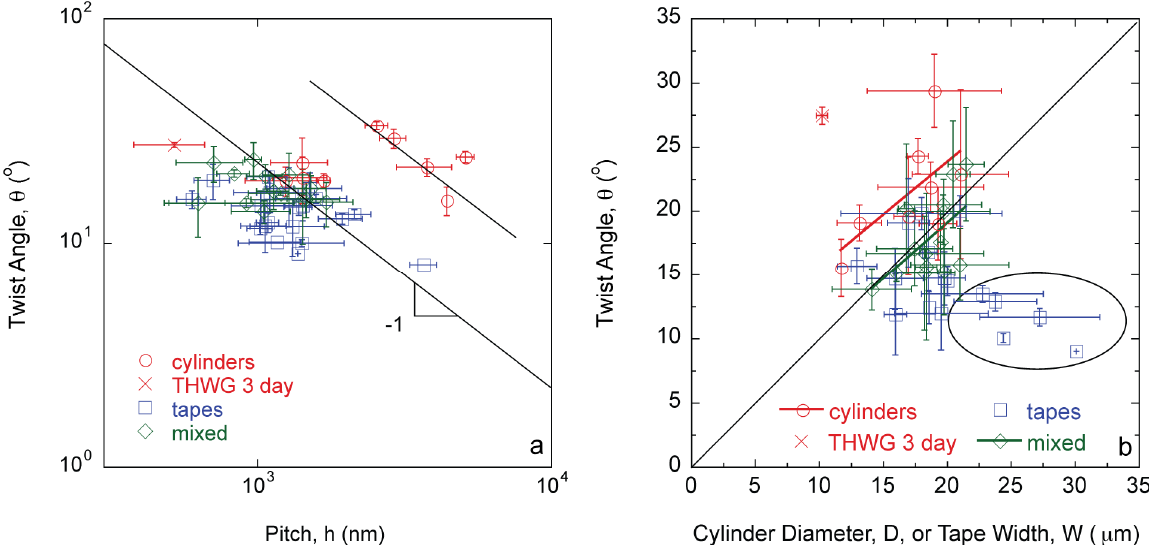
Figure 2. Twist angle, θ , is ( a ) inversely proportional to pitch, h; and ( b ) directly proportional to fiber diameter, D, and tape width, W, following Equations (1) and (2). Fully formed THWG fibers have higher θ and h